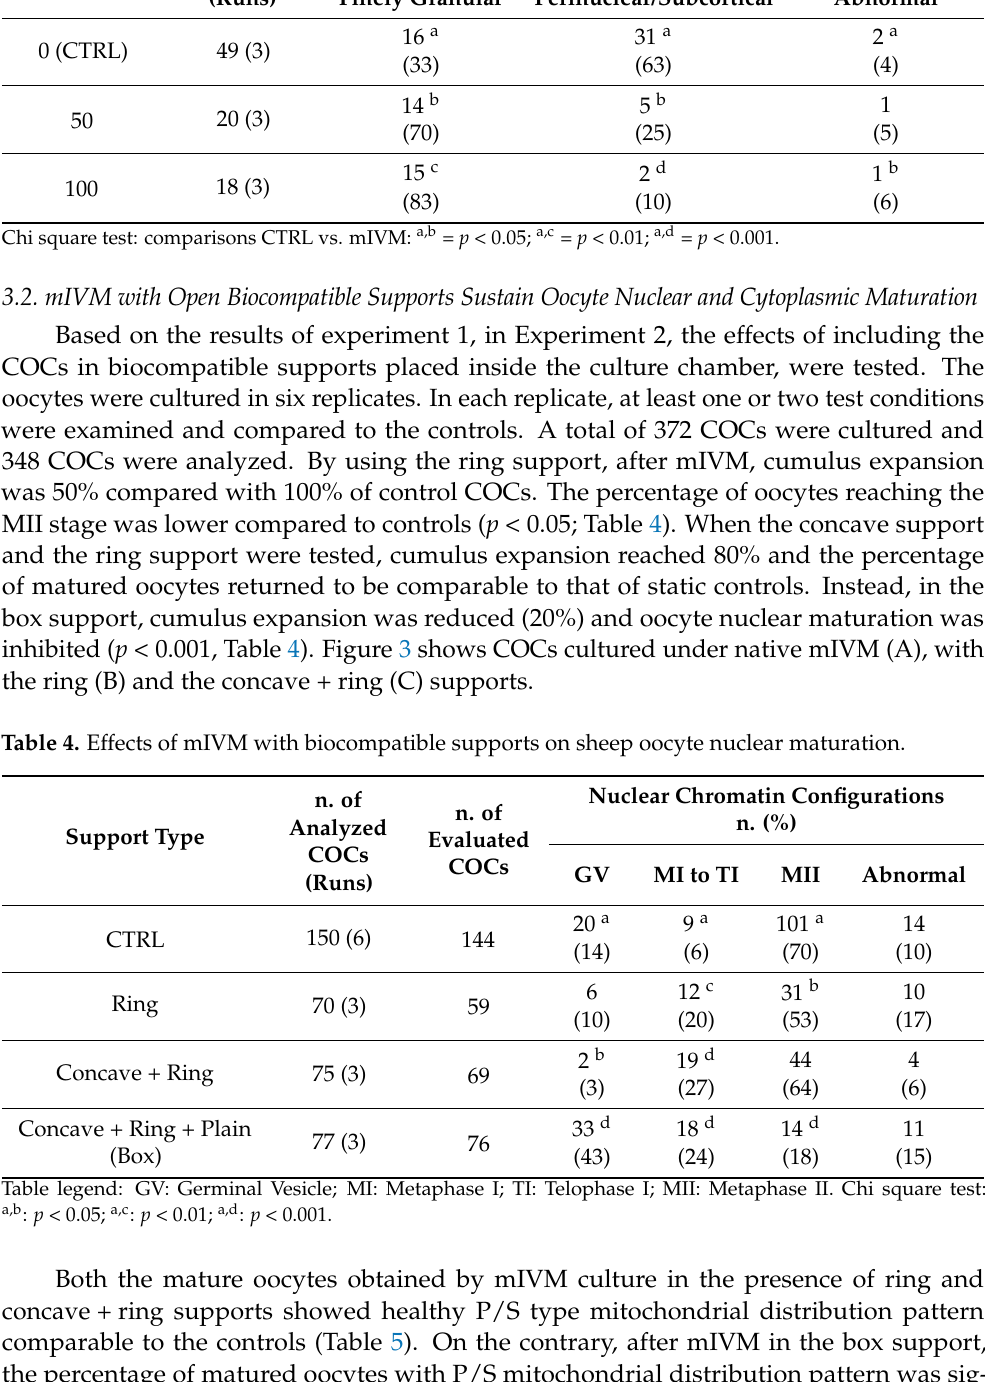
Table legend: GV: Germinal Vesicle; MI: Metaphase I; TI: Telophase I; MII: Metaphase II. Chi square test: